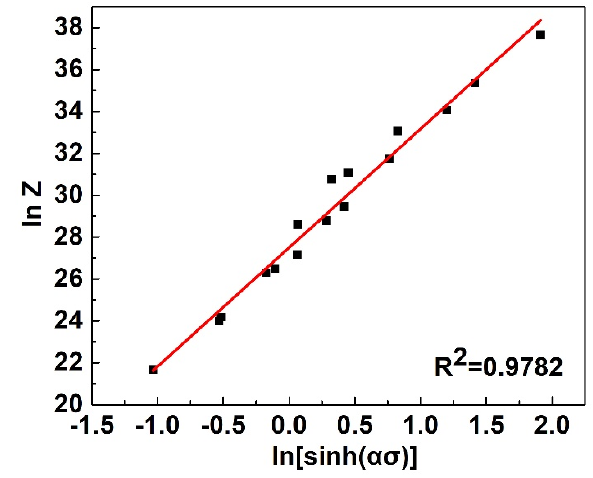
Figure 5. The relationship between ln Z and ln sinh( α 𝜎 (cid:3017) ) By substituting the value of α , A , n , and Q into Equation (5), the deformation con- stitutive equation of Mg-3Sn-2Al-1Zn-0.6Nd alloy suitable for all stress states can be ex- pressed as follows: